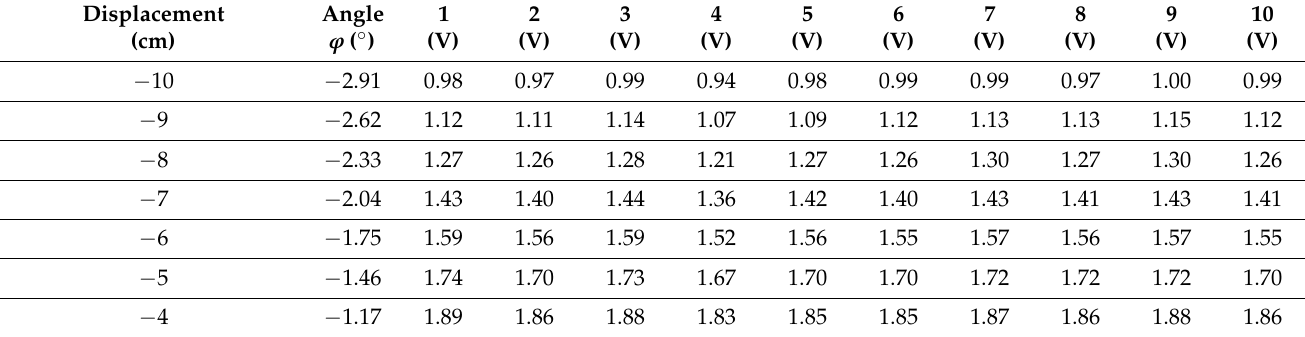
Table 1. Measured